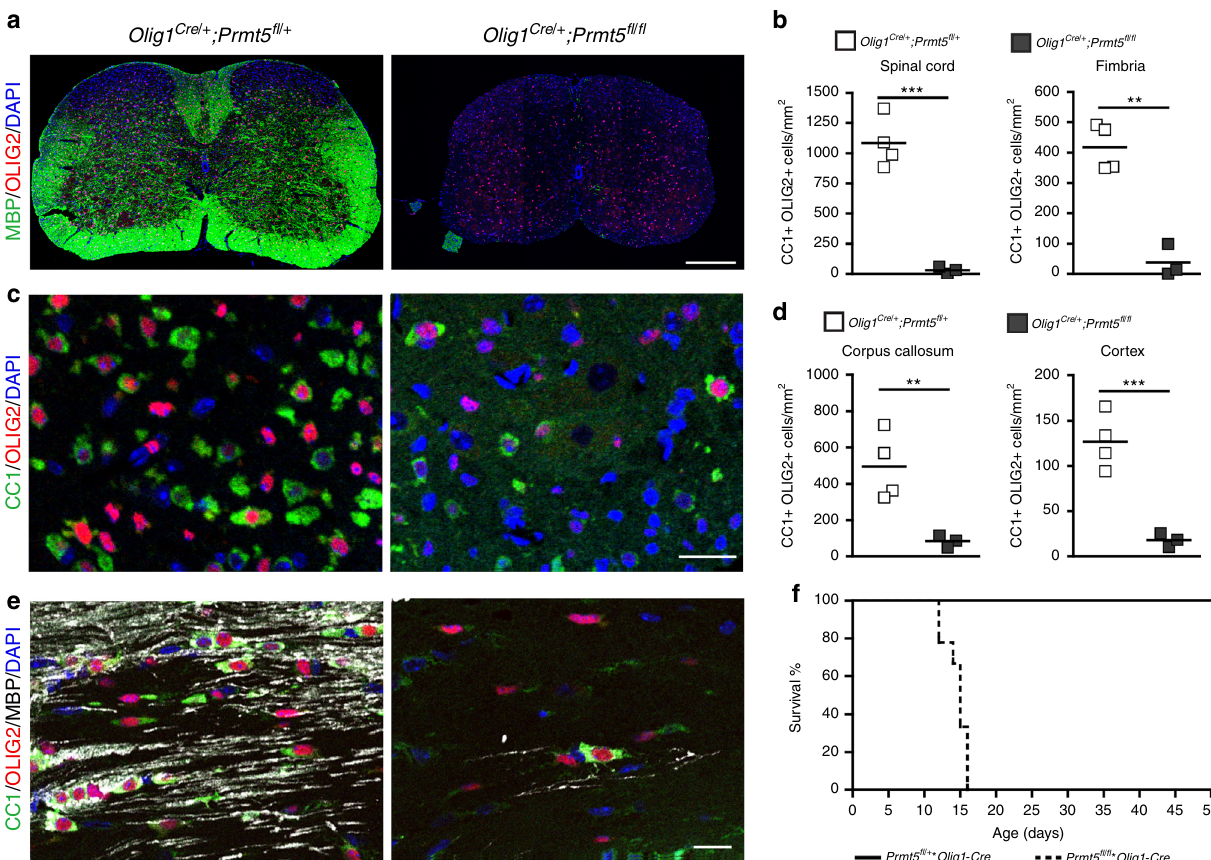
Fig. 2 Genetic ablation of Prmt5 in OPCs induces severe hypomyelination and impaired OPC differentiation. Confocal images of P14 spinal cord ( a ) and corpus callosum ( c , e ) sections from controls (Olig1 Cre/ + ; Prmt5 fl / + ) and Prmt5 mutants ( Olig1 Cre/ + ; Prmt5 fl / fl ) stained for MBP ( a : green, scale bar = 200 μ m; e : white, scale bar = 20 μ m), CC1 ( c , e : green, scale bar = 20 μ m), OLIG2 ( a : red, scale bar: 200 μ m; c , e : red, scale bar = 20 μ m). DAPI (blue) as nuclear counterstain. ( b , d ) Scatter plot represents the average number of CC1 + /OLIG2 + cells quanti fi ed in spinal cord and fi mbria ( b ) and in corpus callosum and cortex ( d ) of four control mice ( Olig1 Cre/ + ; Prmt5 fl / + ) and three Prmt5 mutants ( Olig1 Cre/ + ; Prmt5 fl / fl ). Student ’ s t test, ** p < 0.01, *** p < 0.001. f Survival curve showing comparison in controls ( Olig1 Cre/ + ; Prmt5 fl / + ) and nine Prmt5 mutants ( Olig1 Cre/ + ; Prmt5 fl /f l